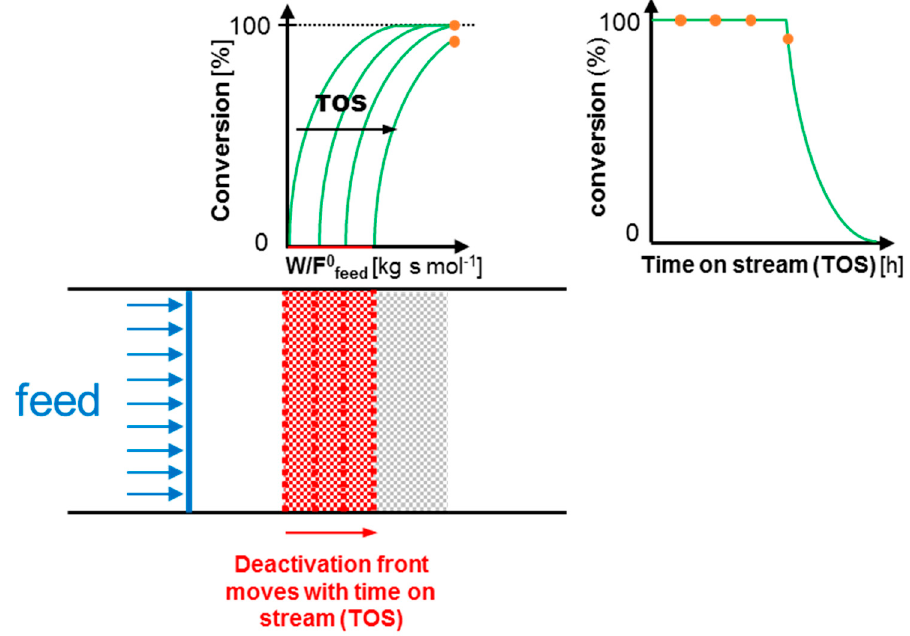
Figure 2. Hypothetical example of catalyst deactivation by off-cycle species poisoning in a plug-flow reactor for the reaction A → B, operated at full reagent conversion level.